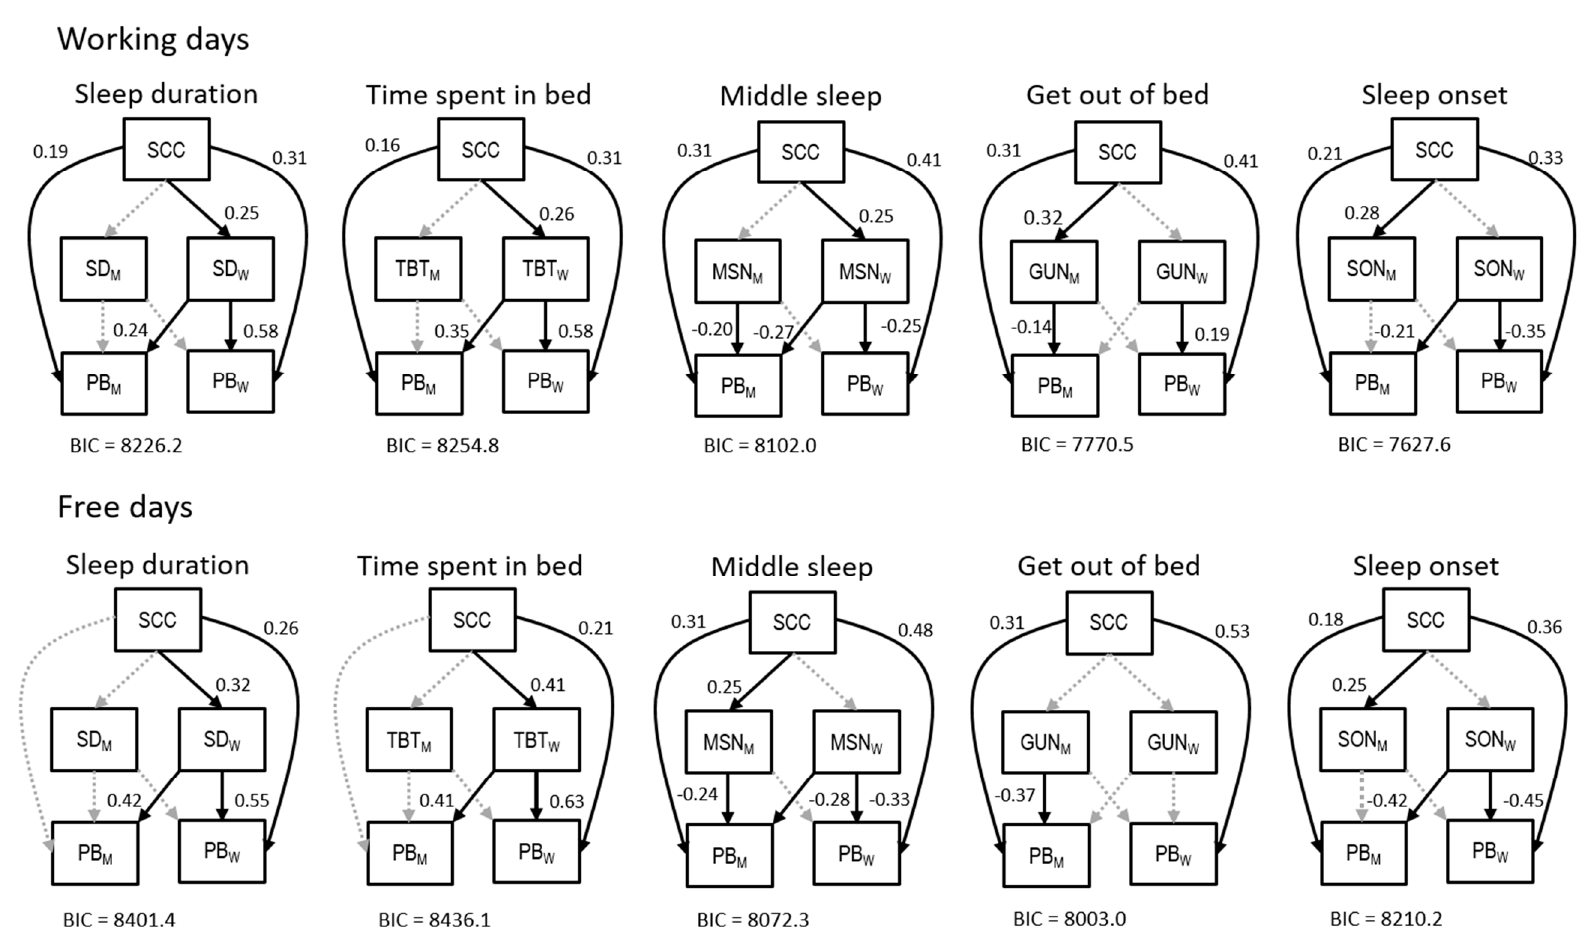
Figure 4. The Actor-Partner Interdependence model performed during free and working days. Note: SCC: Child sleeping quality score, PB: Partner relationship score, SD: Sleep duration, TBT: Time spent in bed, MSN: Middle sleep, GUN: Time getting out of bed, SON: Sleep onset.